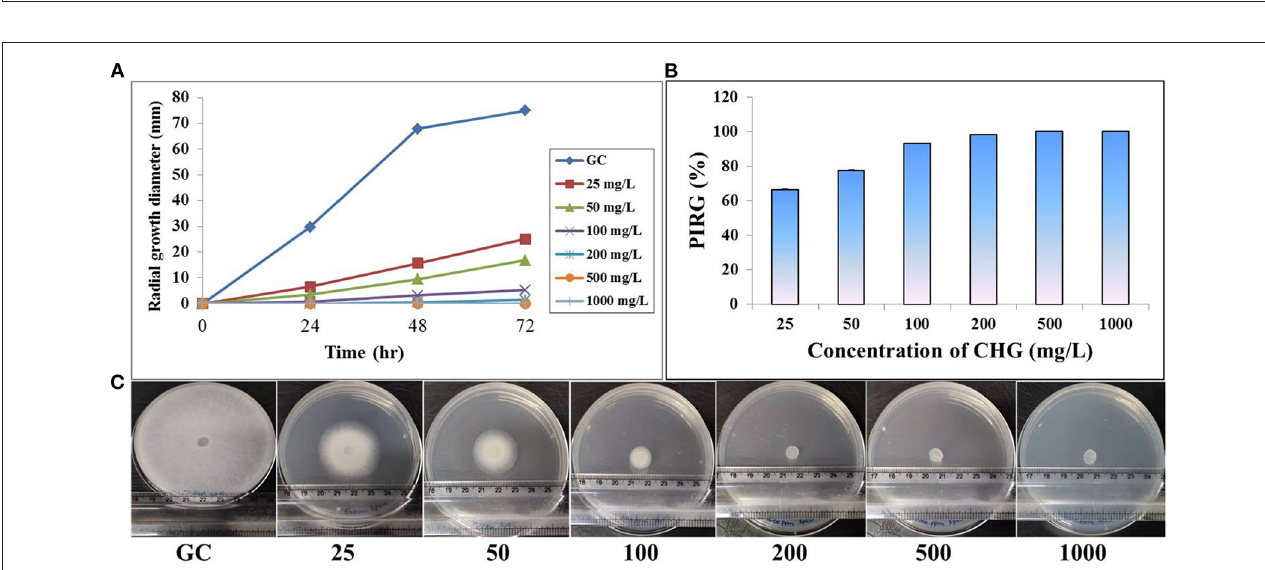
FIGURE 2 | Determination of minimum inhibitory concentration (MIC) and minimum fungicidal concentration (MFC) of CHG against Saprolegnia. Series of wells with blue and pink color at the top is of resazurin assay for determination of MIC. (A) MIC (blue) and MFC is 50 mg/L for S parasitica, (B) MIC is 100 mg/L and MFC is 200 mg/L for S. australis . Values are concentration of CHG in mg/L. GC, Growth control; SC, Sterile control. In wells of MIC and above, there is no development of pink color. In MFC, hyphal growth is absent.